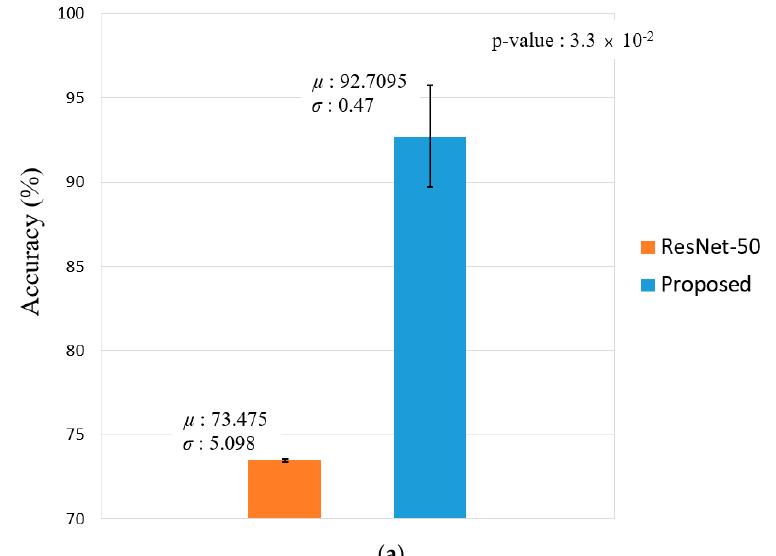
obtained by the proposed and state-of-the-art methods.